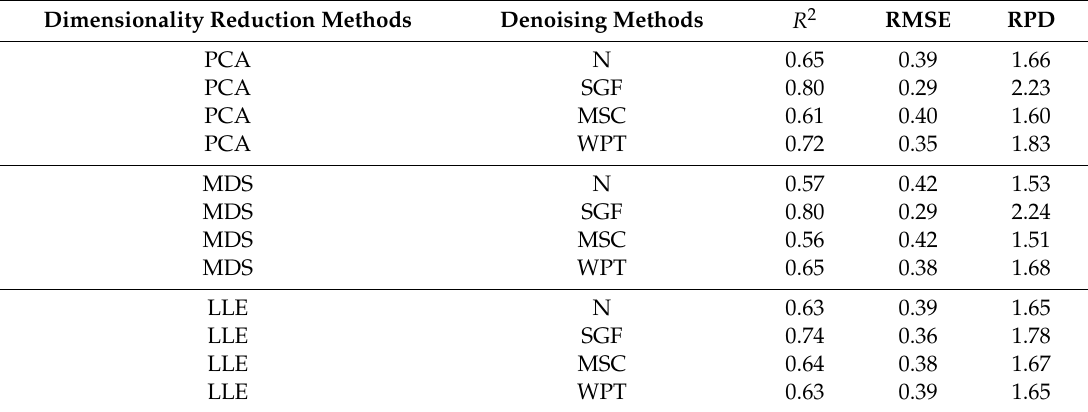
Table 3. SOM Content Estimation Model Accuracy without Fractional